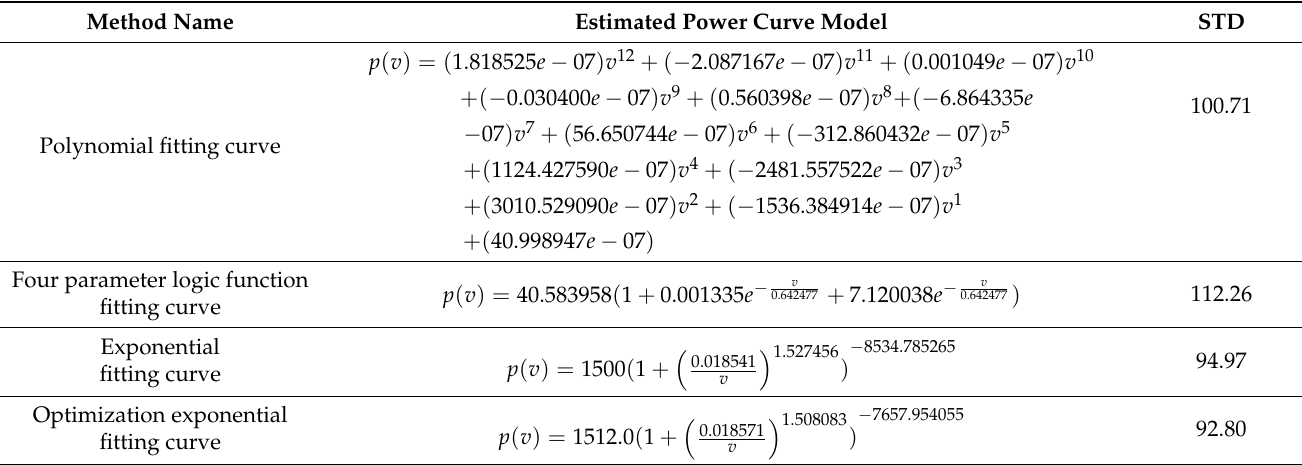
Table 7. Fitting parameters of four power curve methods and standard deviation (STD).